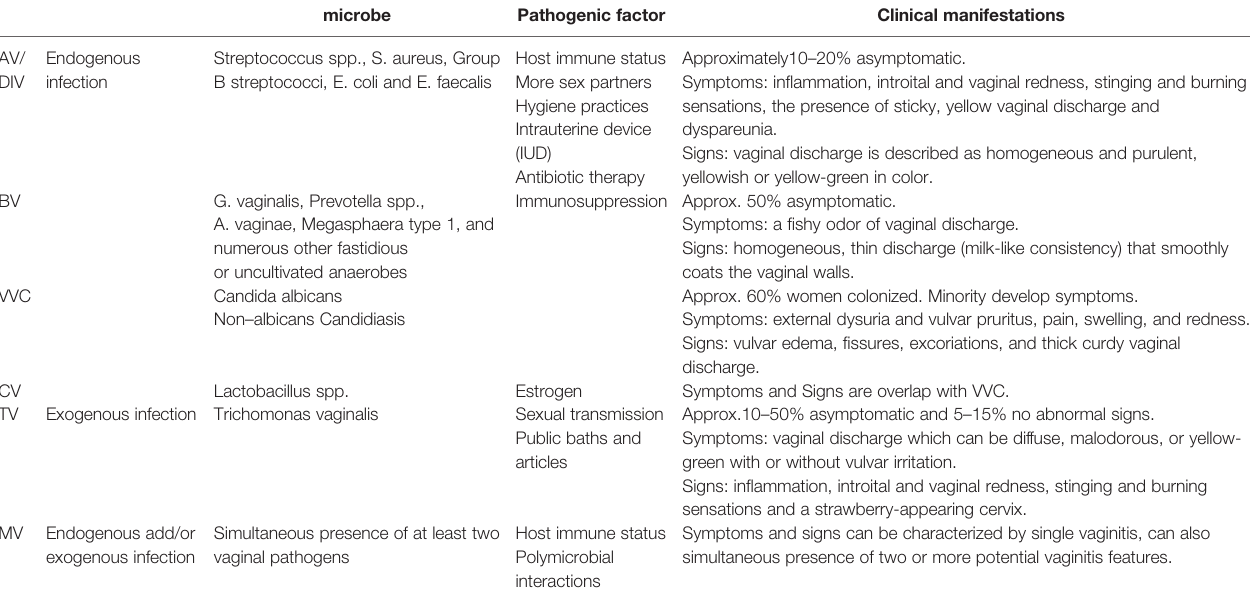
TABLE 2 | A comparing the clinical manifestations and opportunistic pathogens in vaginitis.